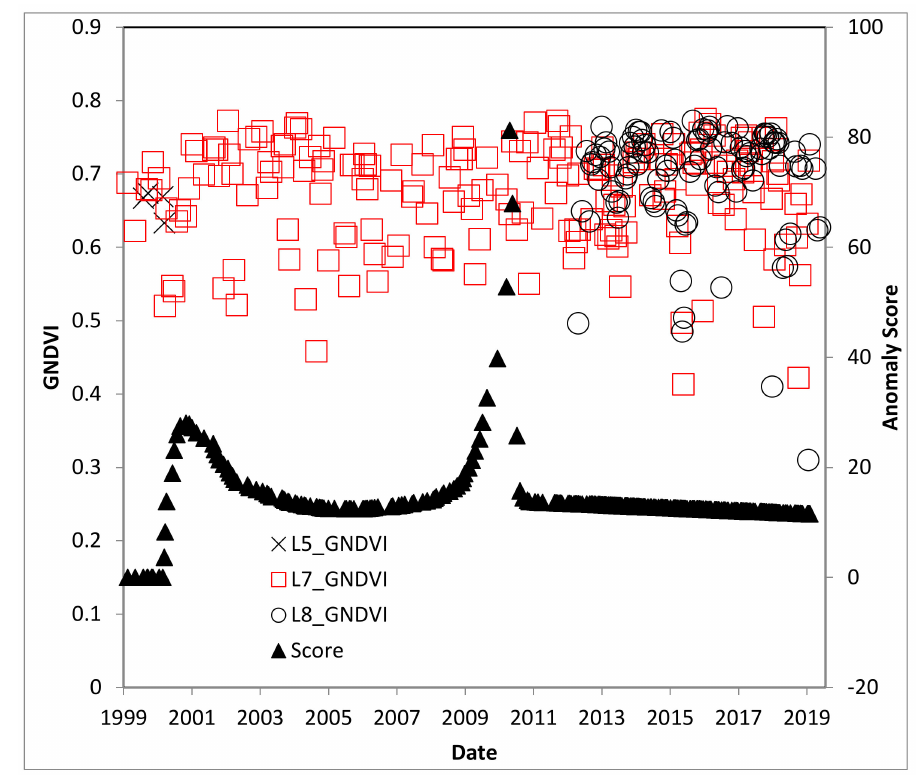
Figure 6. GNDVI time series for the Trinidad study site, with L5-TM prior to 2013, L8-OLI after 2013, and Landsat 7 Enhanced Thematic Mapper (L7-ETM + ) for the entire period. R. indica was first observed in 2006.